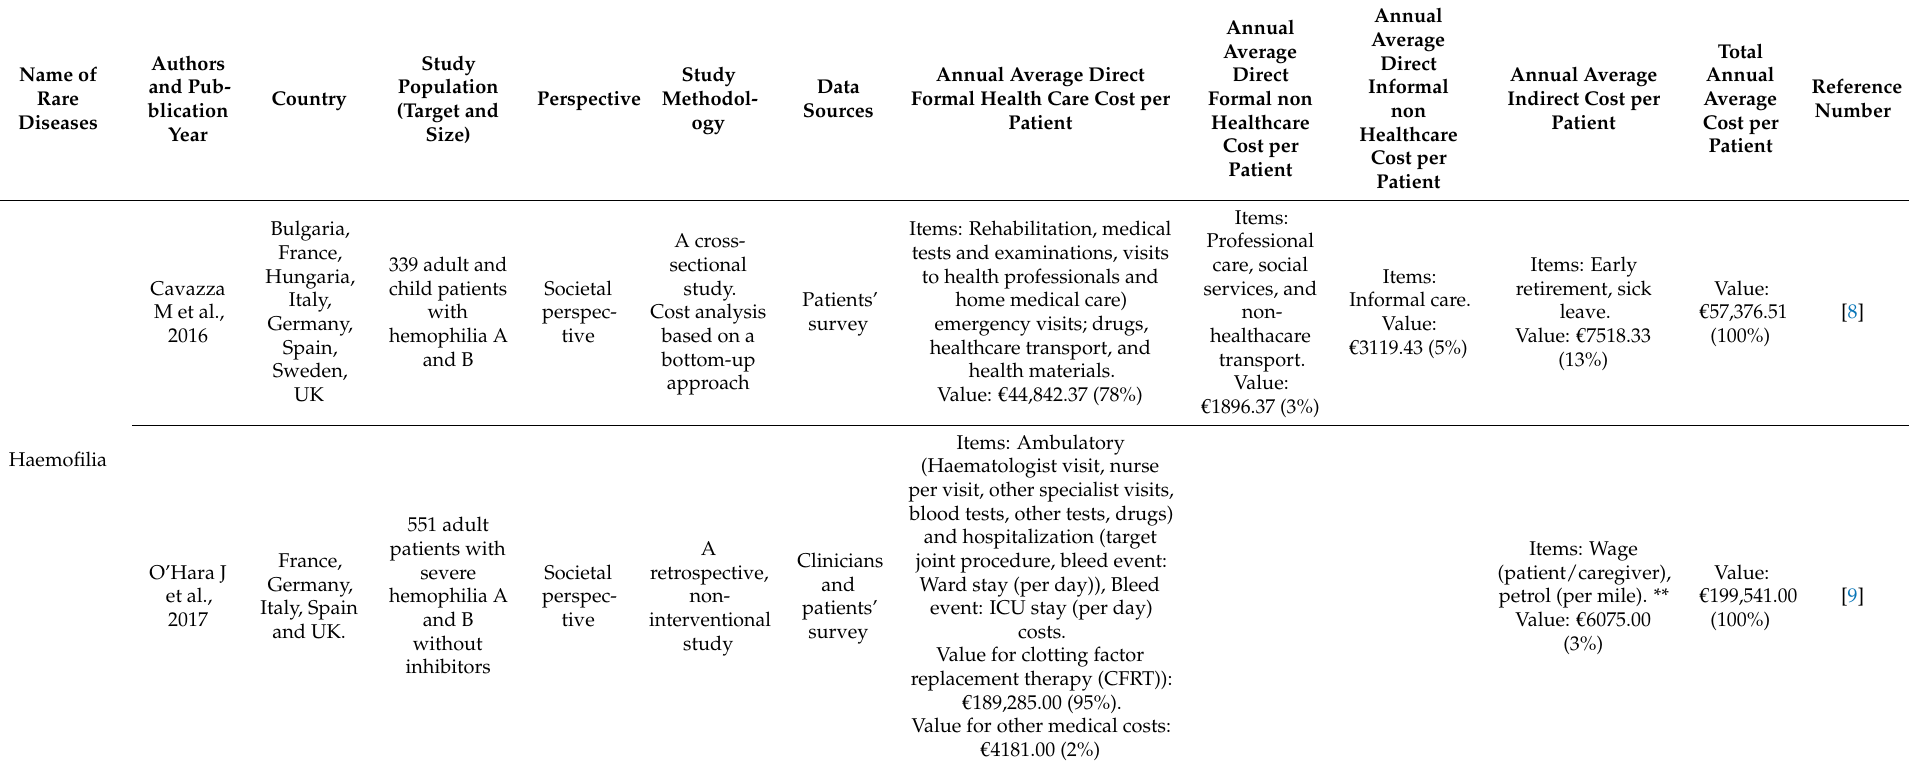
Table 1. Samples of cost of illness studies concerning the selected rare